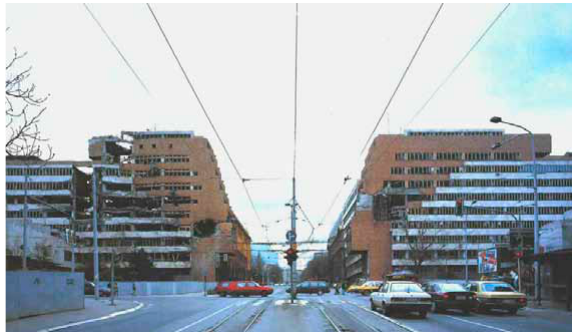
fig. 4. The army Headquarters after the 1999 bombardments and redefined recognisability. The Building a with significant damage and the Building B with slight damage and demol- ished entrance pavilion (on the far right). Source : Kovačević